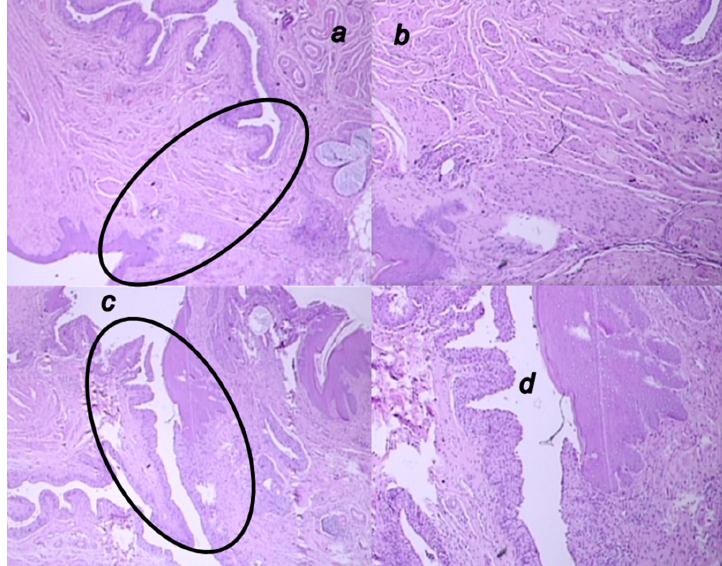
Figure 14. Microscopic presentation of eight-week vesicovaginal fistula, after the six-week therapy of fistulous rats in the BPC 157 treated rats ( a , b ) and control rats ( c , d ). ( a , b ) Visible mature epithelialization, formed epithelium, closed fistula (circle), fully formed collagen fibers and significant neovascularization with the formation of new blood vessels and mature granulation tissue in the BPC 157-rats (HE; ×20 ( a ), ×100 ( b )). ( c , d ). Visible open vesicovaginal fistula code (circle) with moderate inflammation of the fistula’s wall in the controls (HE; ×20 ( c ), ×100 ( d )).